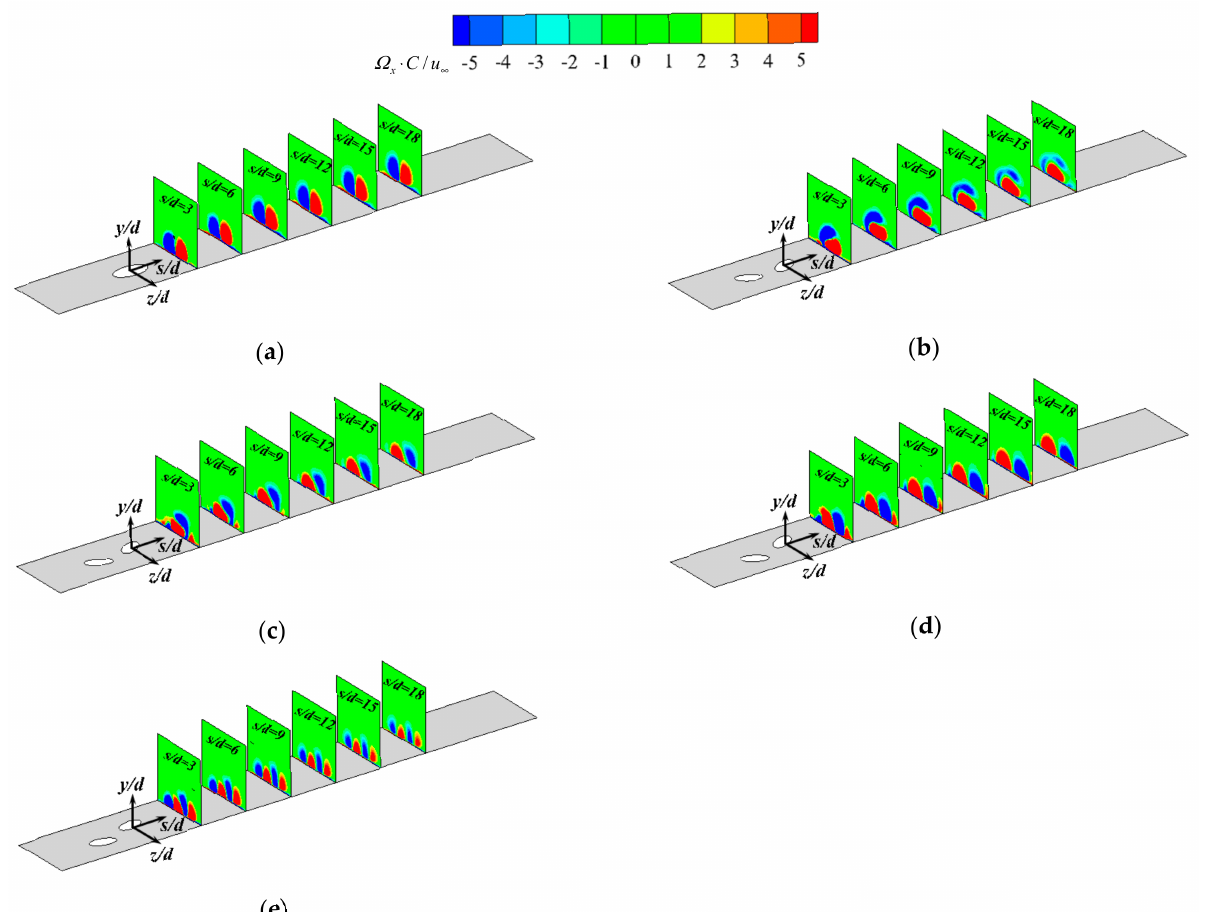
Figure 11. Streamwise vorticity distributions in downstream normal sections for some situations under M = 1.5. ( a ) cylindrical hole, ( b ) Z / d = 0, β = 29 ◦ , ( c ) Z / d = 0.5, β = 29 ◦ , ( d ) Z / d = 1.0, β = 29 ◦ , ( e ) Z / d = 1.0, β = 11 ◦